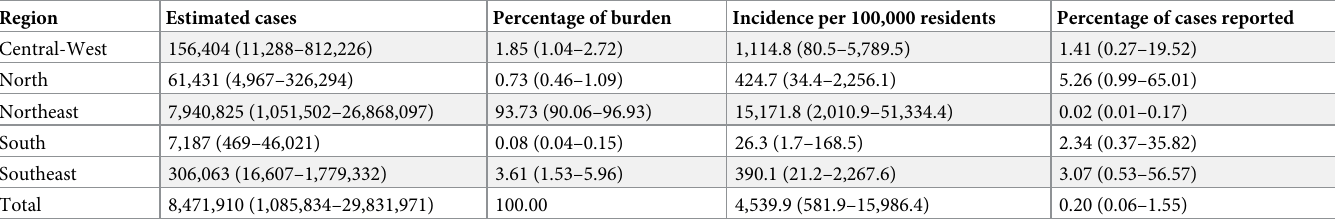
Table 2. Estimated total symptomatic Zika cases over the course of the outbreak (January 2015–May 2017).